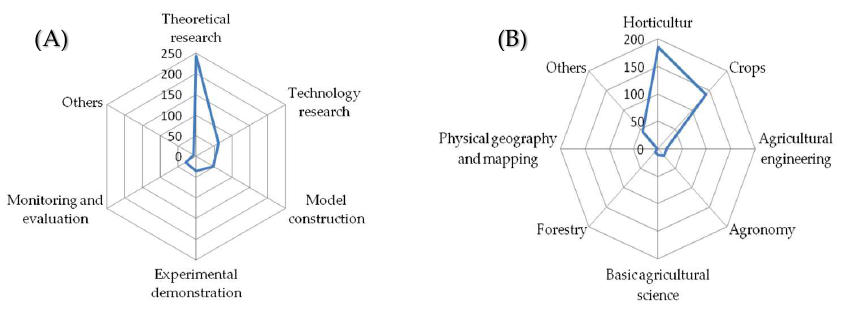
Figure 2. Distribution of literature levels ( A ) and subject areas ( B ).